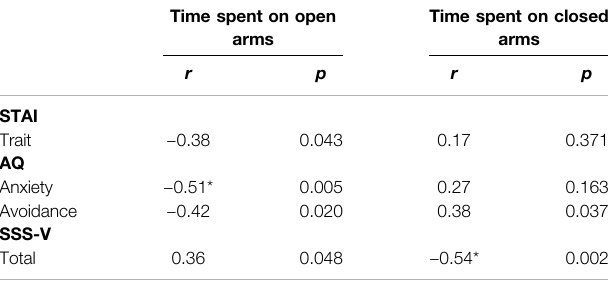
TABLE 1 | Results of correlation analyses of time spent on open or closed arms and psychometrics. Time spent on open arms